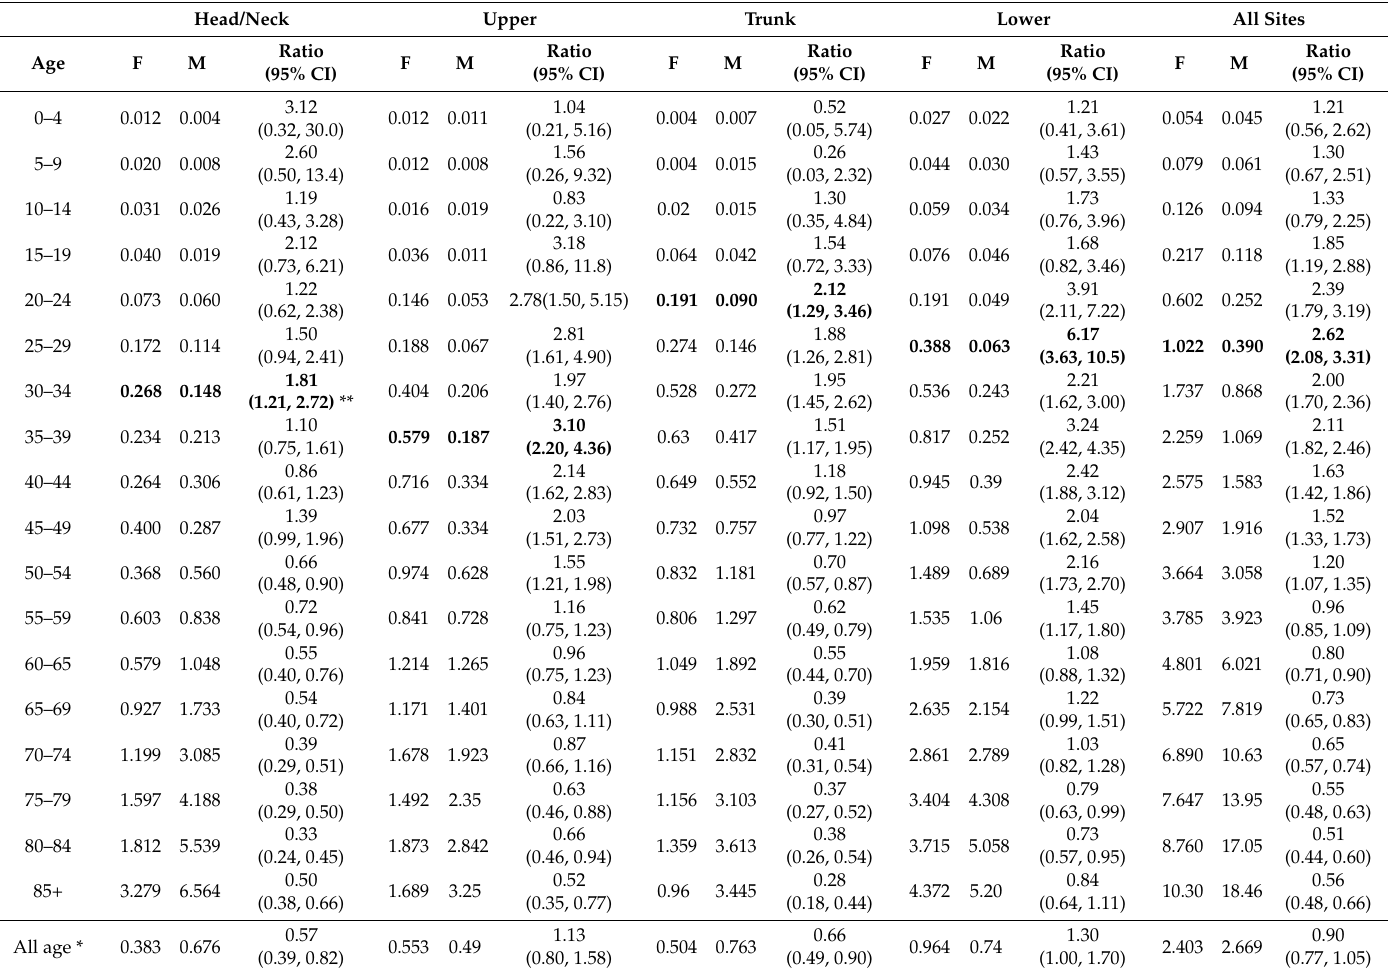
Table 3. Age- and site-specific incidence rates (per 100,000 person-years) and rate ratios (F/M) in the non-white populations. Head/Neck Upper Trunk Lower All